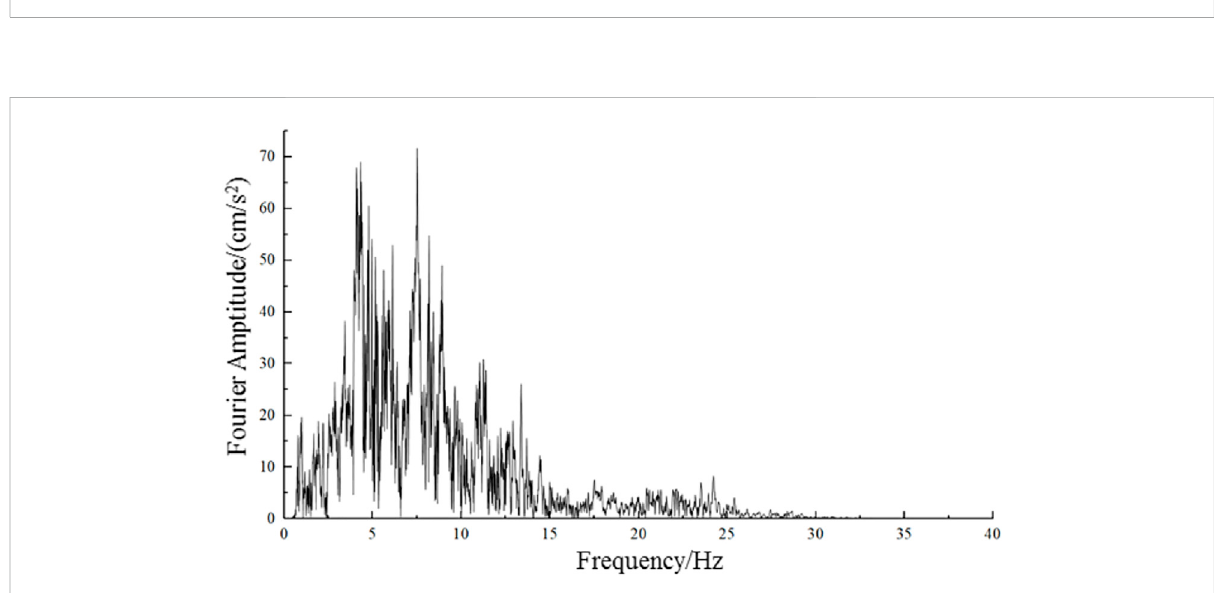
FIGURE 6 Seismic spectrum of the horizontal component of the Minxian seismic